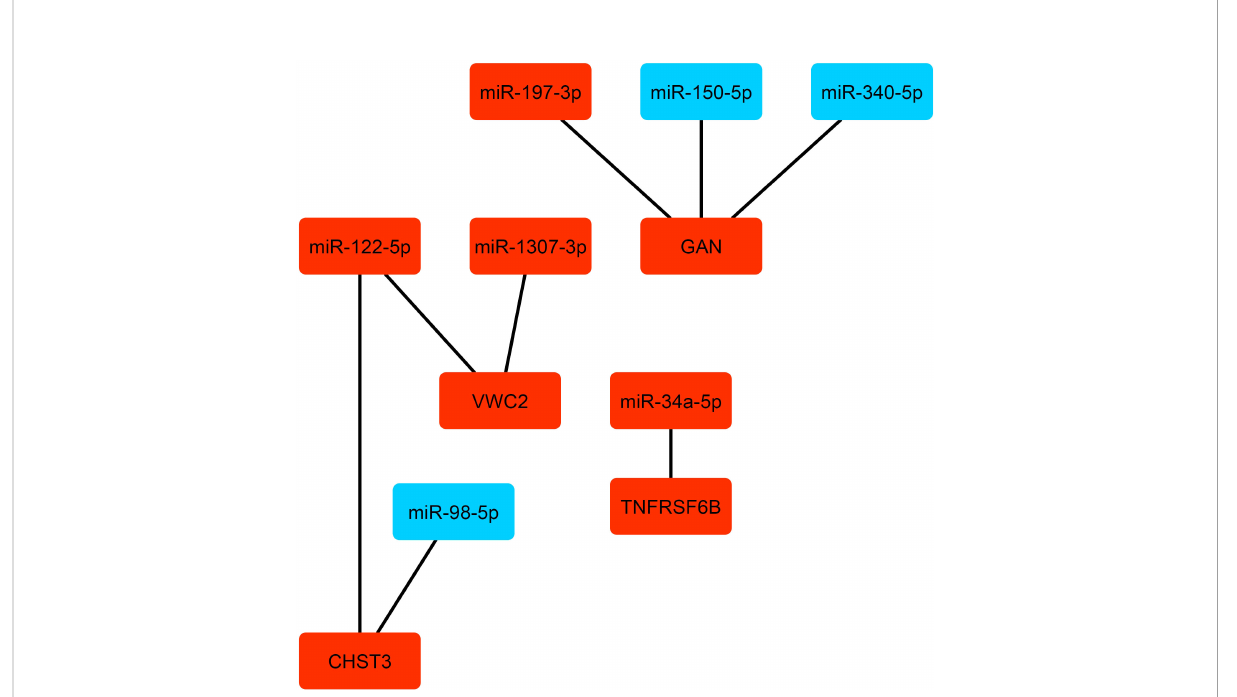
FIGURE 8 The miRNAs-target gene network. The up-regulated and down-regulated miRNA and genes are depicted by red and blue colors,